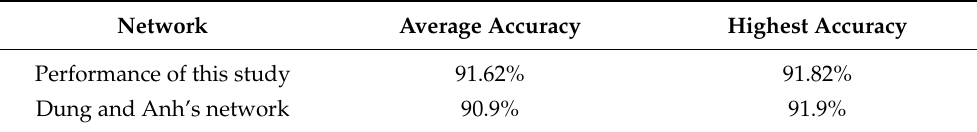
Table 6. Performance comparison of this study and Dung and Anh’s study.